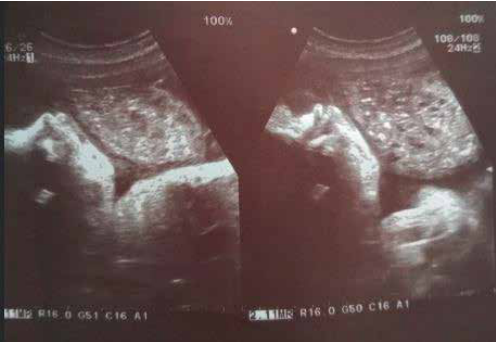
1: Ultrasound showing a heterogeneous cystic lesion anteriorly and a normal fetus.